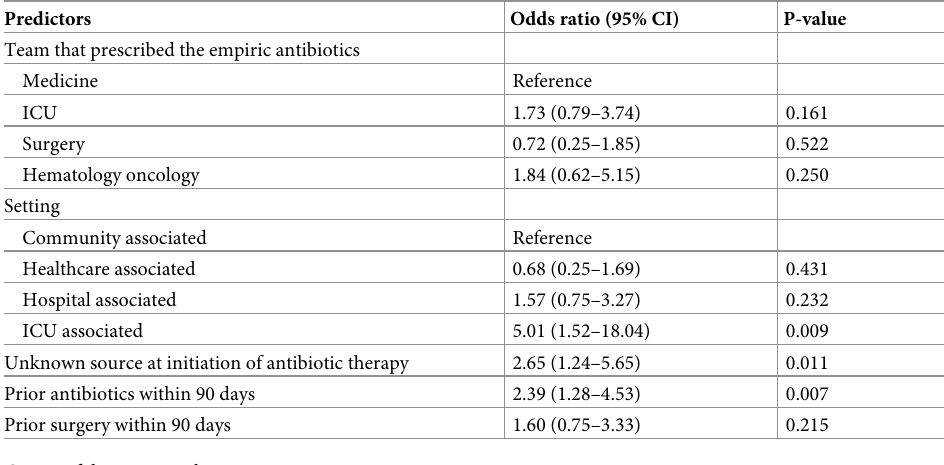
Table 4. Univariate analysis of predictors of inadequate empiric antibiotic therapy.